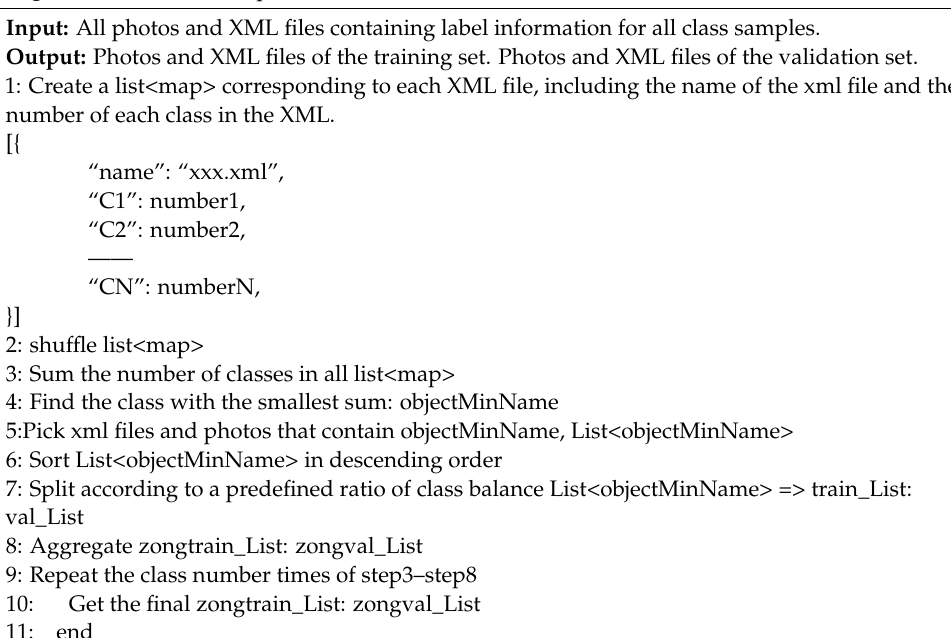
Algorithm 1: Train/Val Split based on